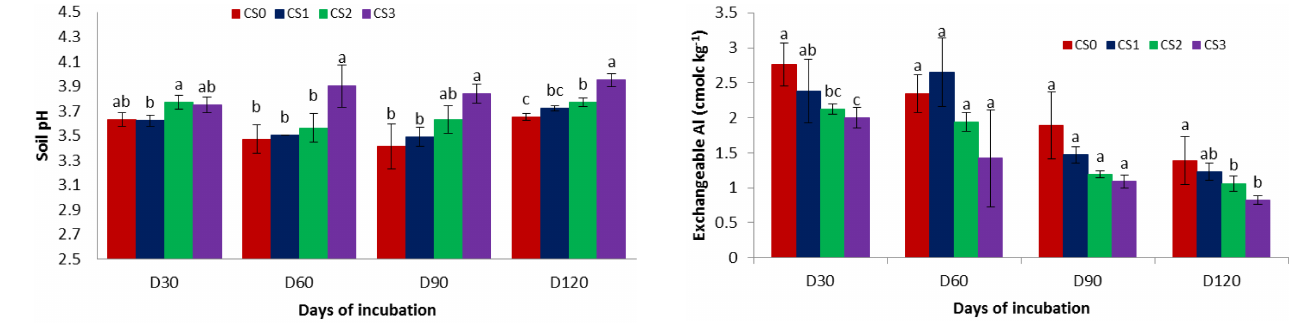
Figure 1. Effects of calcium silicate application on soil pH under submerged conditions. Means marked with the same letter for each incubation day are not significantly different at p< 0 . 05 (Tukey‘s test).